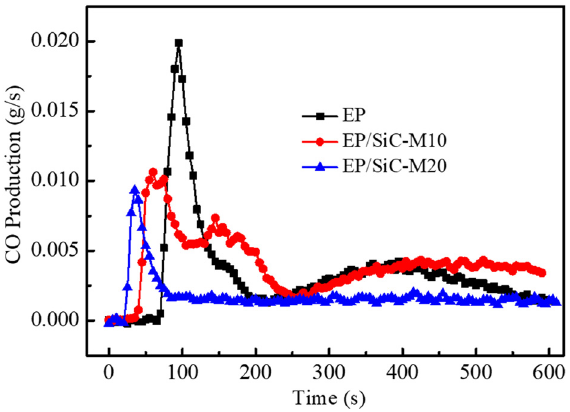
Figure 8: CO production rate versus time curves of EP and compo - sites EP/SiC -